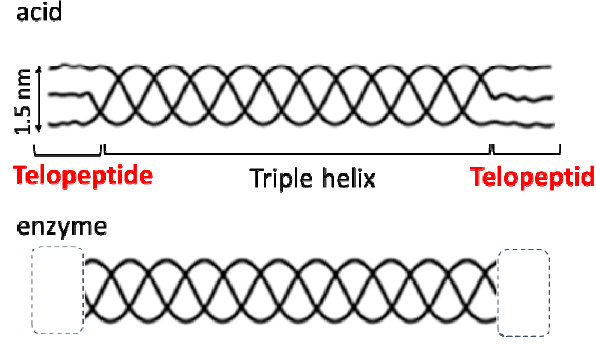
Figure 2. Collagen materials obtained by acid and enzyme treatment.